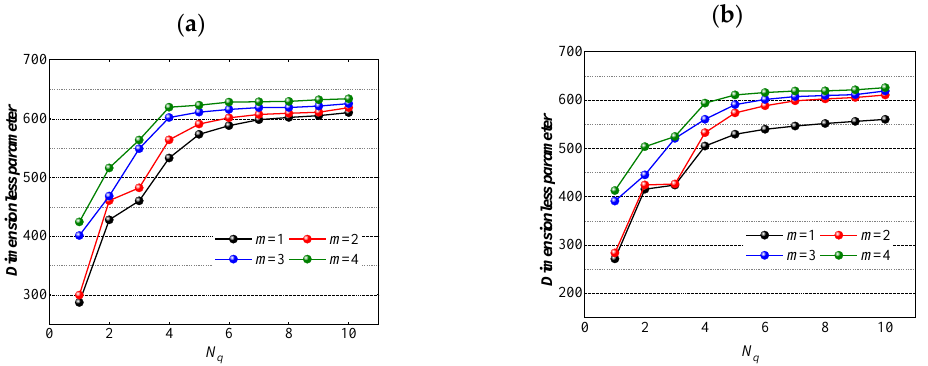
Figure 5. Variation of frequency parameter of LCDCSS with a various number of annular plates.